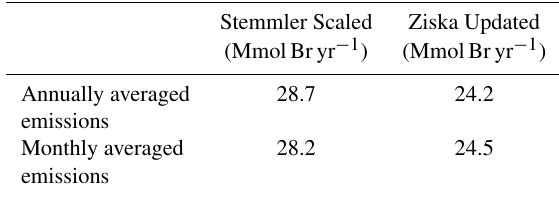
Table 4. Total annual stratospheric injection of bromoform emitted from the IO/WP